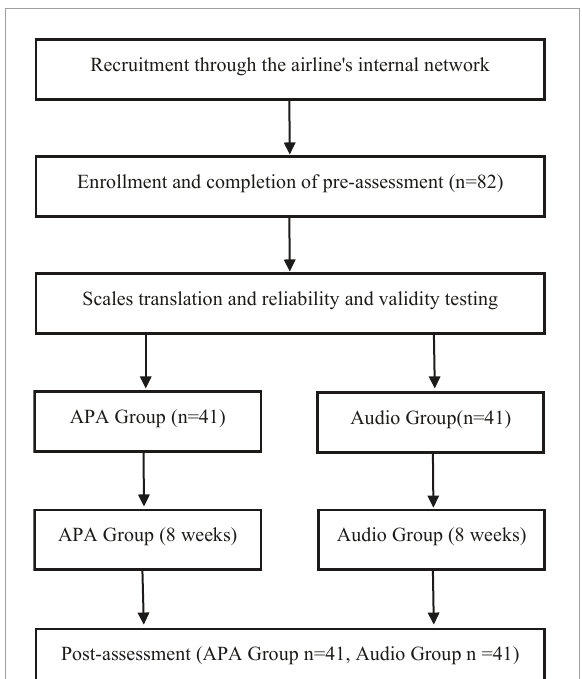
FIGURE2 Procedure